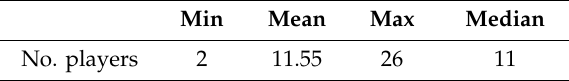
Figure 11. Visual representation of intersection over union (IoU) criteria equal to or greater than 50%. The results of the detector greatly depend on the complexity of the scene, which in the used dataset depends on the number of players on the scene and their size, as well as on the distance from the camera and the number of occlusions. For example, if there are up to eight players on the scene, close to the camera, the results are significantly better than in the case when there are nine or more players on scene that are far from the camera and occlusions exist, as shown in Figure 12. The